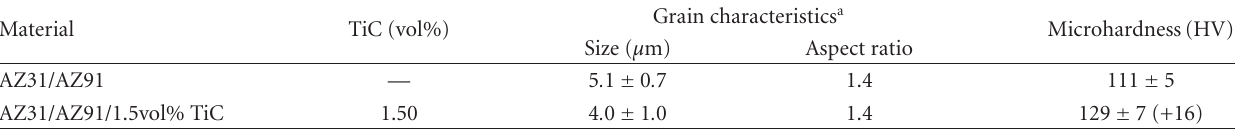
Table 1: Results of grain characteristics and microhardness of AZ31/AZ91 and AZ31/AZ91/TiC nanocomposite.